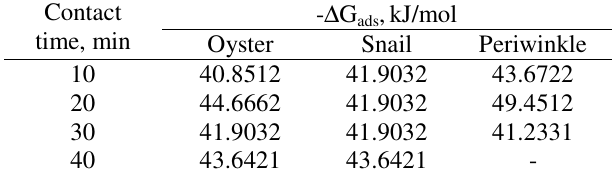
Table 4. Values of ∆ G for adsorption of Pb 2+ by oyster, snail and periwinkle shells. ads